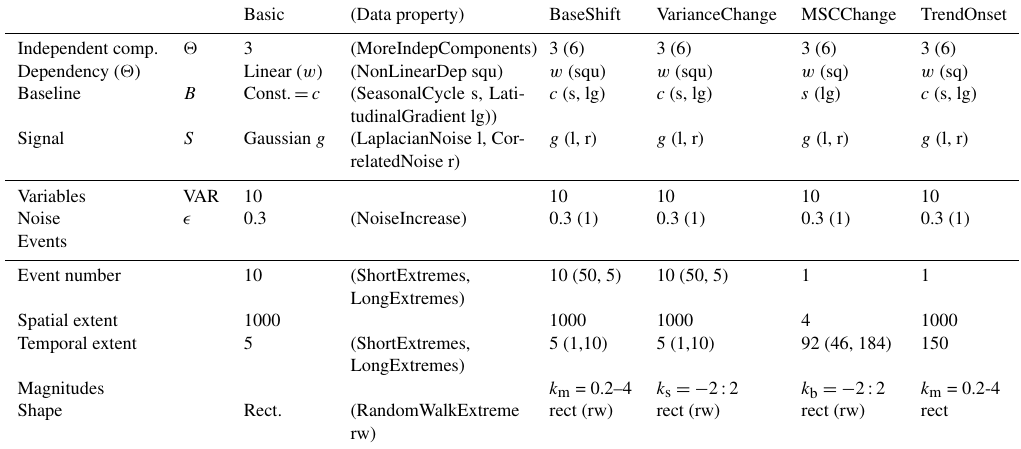
Table A1. Parameter settings for the generation of the artificial data farm. Details are given for each event type and data property (in brackets). Basic (Data property) BaseShift VarianceChange MSCChange